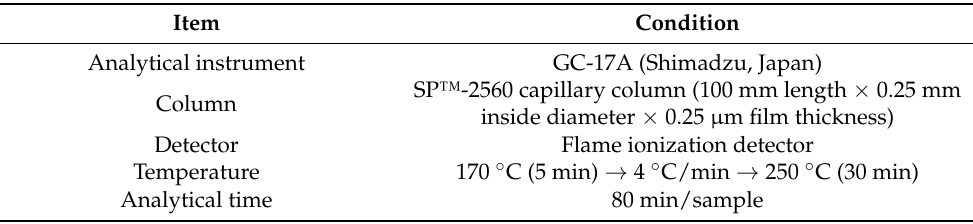
Table 1. Analytical gas chromatography conditions used to study the fatty acid compositions. Item